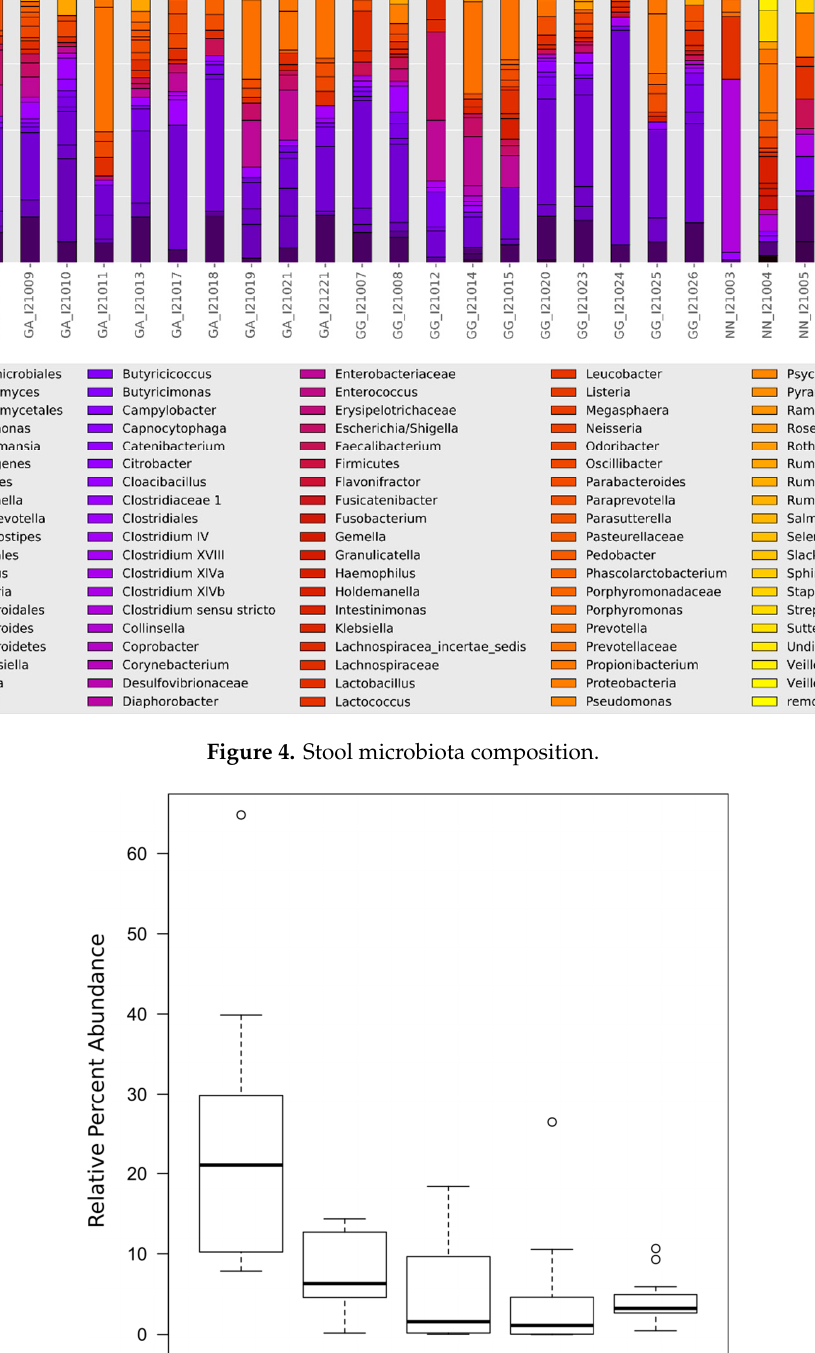
Figure 5. Boxplot of most abundant taxa from all the samples.